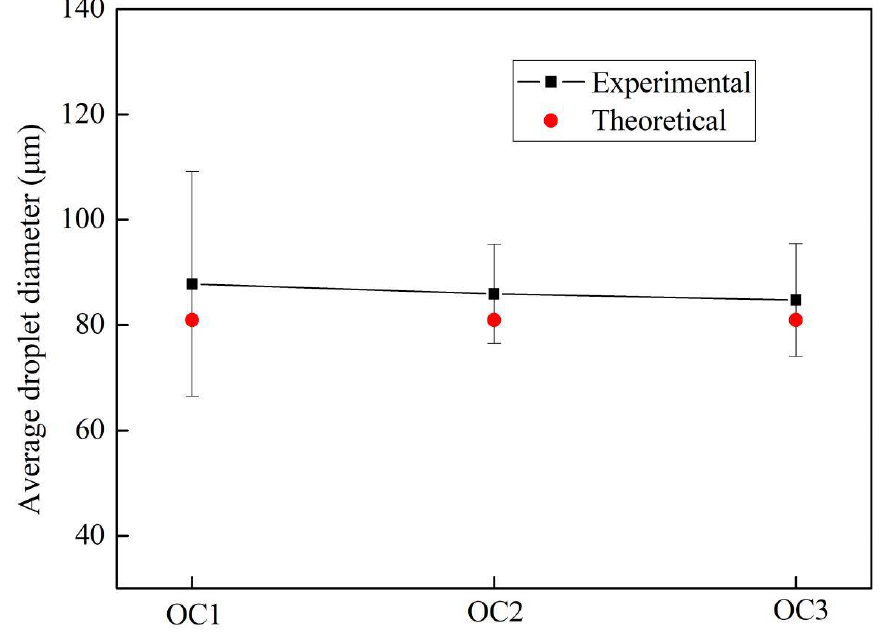
Figure 12. Average diameters of theoretically and experimentally generated monodisperse droplets.